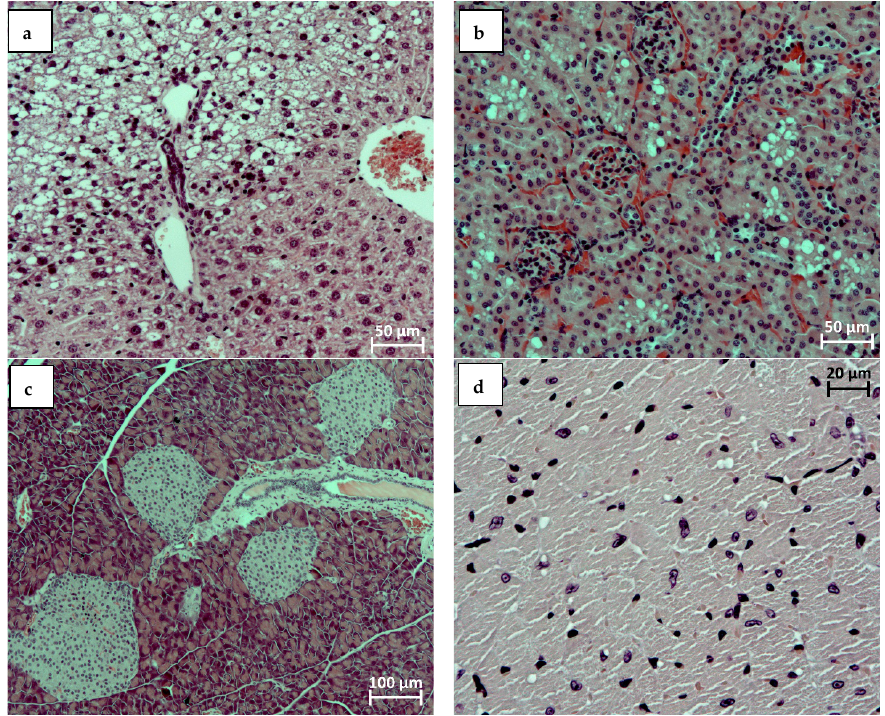
Figure 2. Fragments of the liver ( a ), kidneys ( b ), pancreas ( c ), and myocardium ( d ) of male C57Bl/6 mice kept on a HFD: focal large droplet fatty degeneration of hepatocytes ( a ); pronounced cytoplasm vacuolization of the epithelial cells of the renal tubules ( b ); hyperplasia of the cells of Langerhans islets ( c ); and small lipid inclusions in the sarcoplasm of left ventricle individual car- diomyocytes ( d ). Stained with hematoxylin and eosin. SW. 200 × ( a , b ), 100 × ( c ), and 50 × ( d